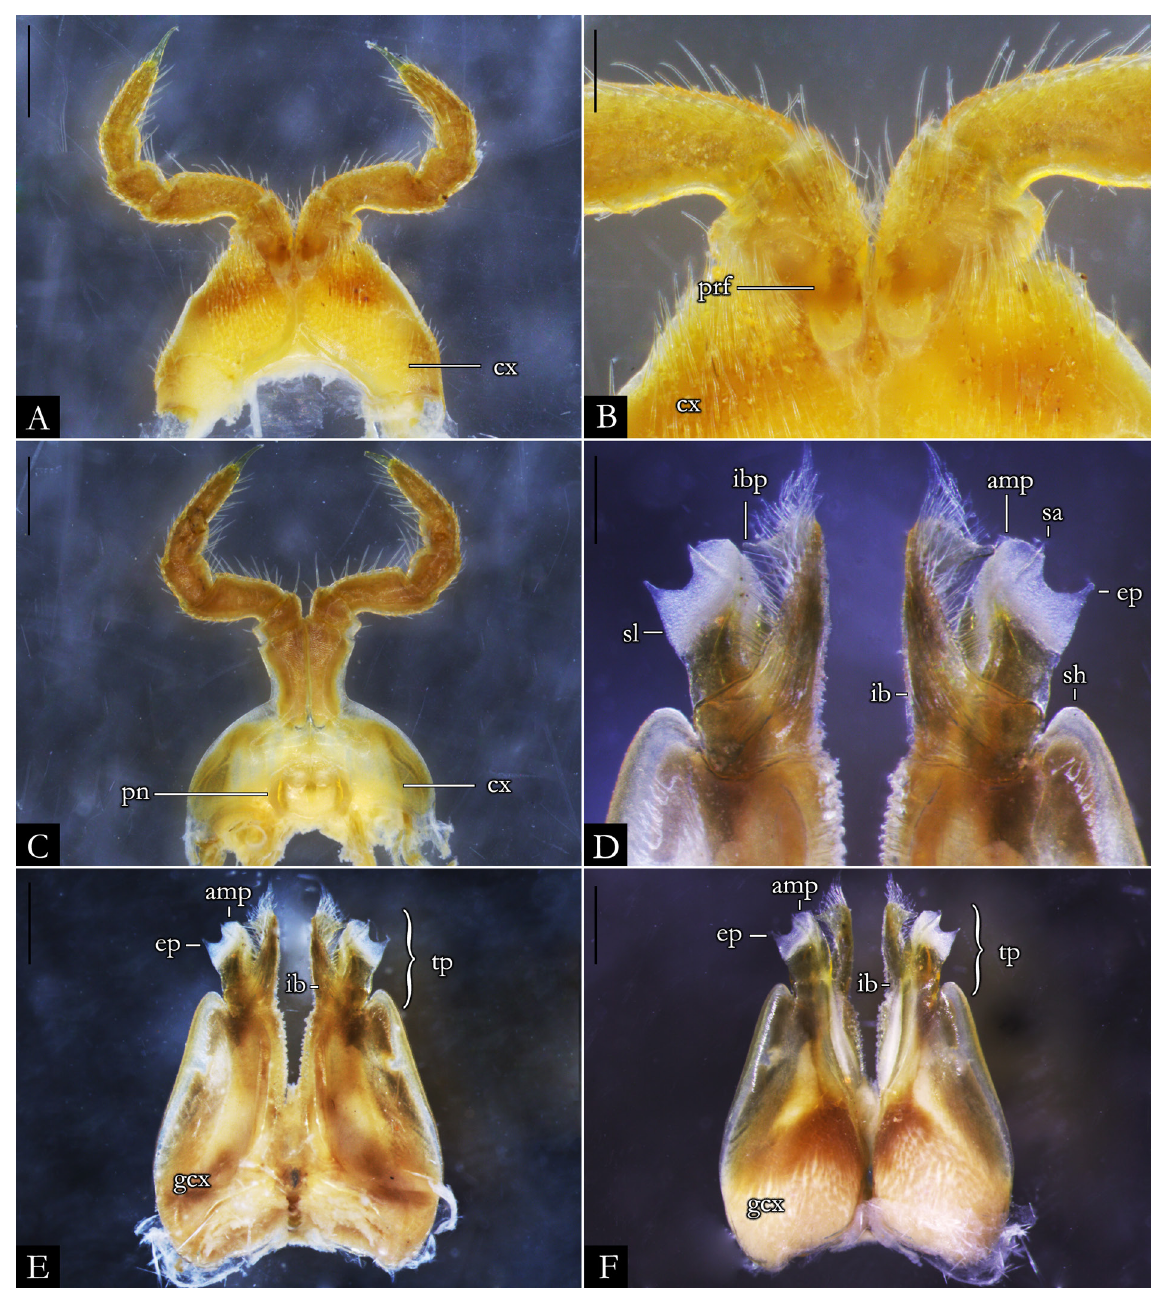
Fig. 69. Pseudonannolene fontanettiae Iniesta & Ferreira, 2014, ♂ (IBSP 3760). A . First leg-pair. B . Detail of prefemur. C . Second leg-pair. D . Detail of telopodites, in anal view. E . Gonopods, in anal view. F . Gonopods, in oral view. Abbreviations: see Material and methods. Scale bars: A, E–F = 0.5 mm; B–D = 0.2